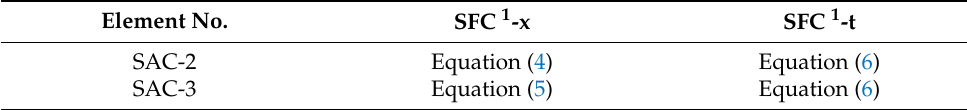
Table 1. The shape functions of different elements. Element